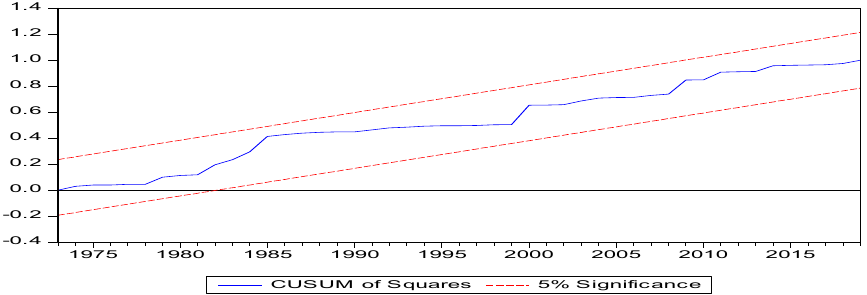
Figure 5. Plot of cumulative sum of recursive residual for Infant Mortality Model.